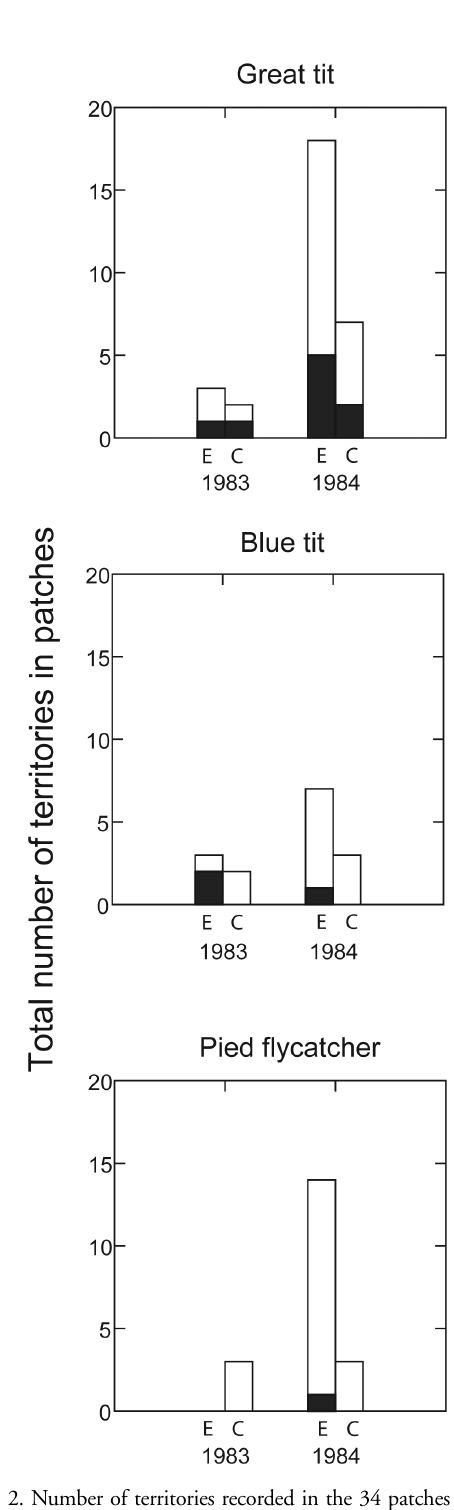
Fig. 2. Number of territories recorded in the 34 patches of the experimental study. E and C denotes experimental (with nest- boxes in 1984) and control patches, respectively. The filled por- tion of the bars represents territories recorded in small patches (< 1